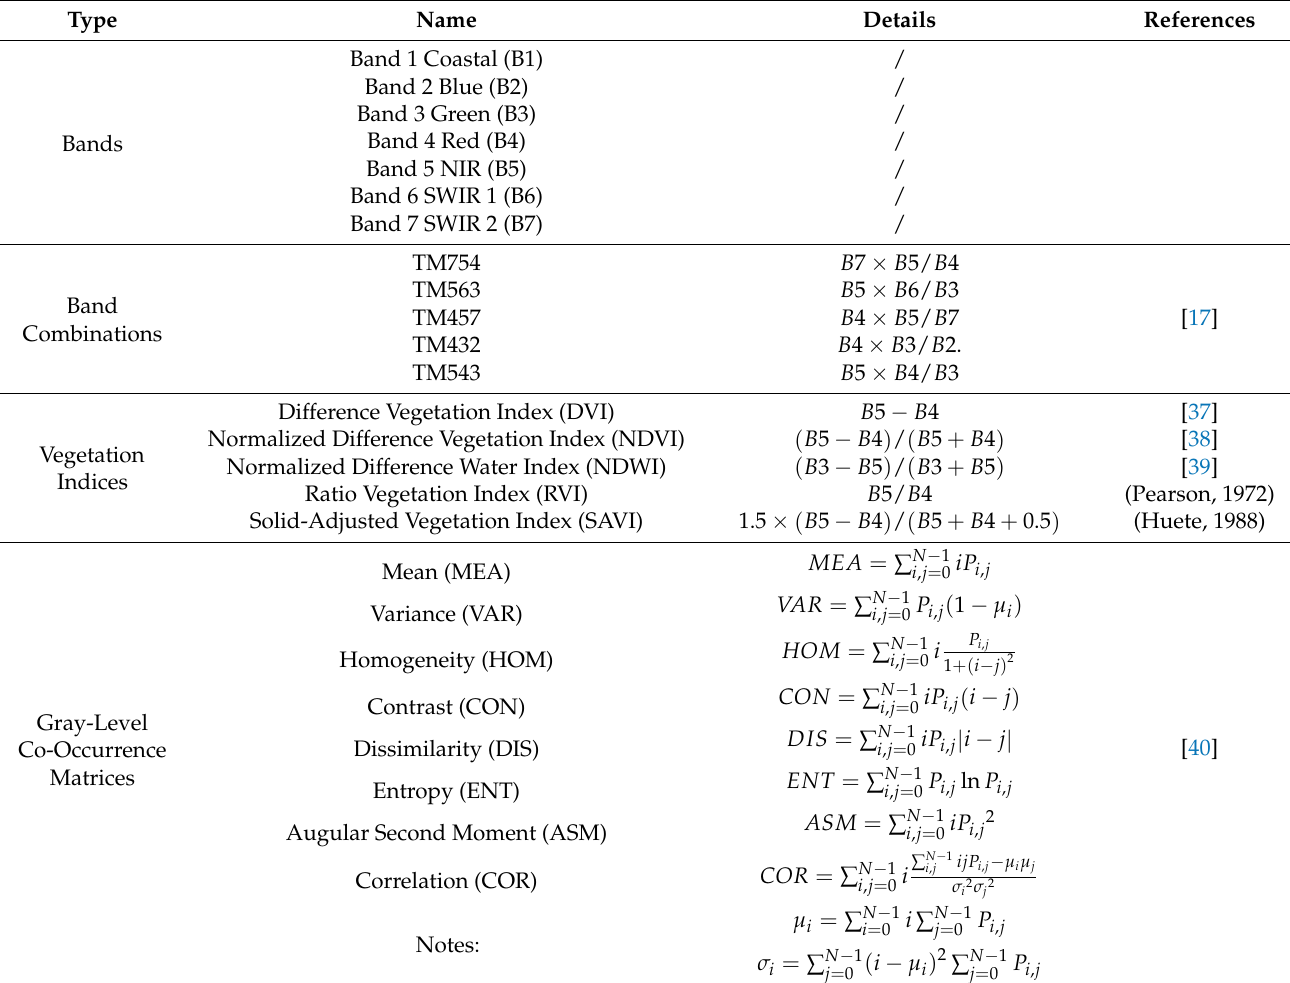
Table 2. The used variables and formulations of